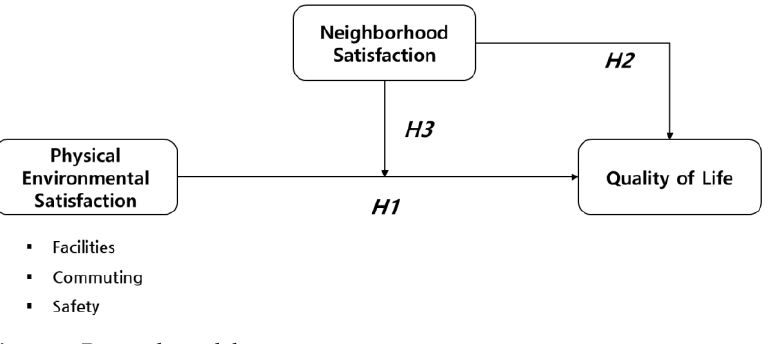
Figure 2. Research